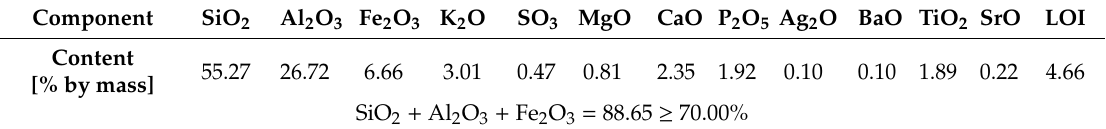
Table 3. Chemical composition of the fly ashes.